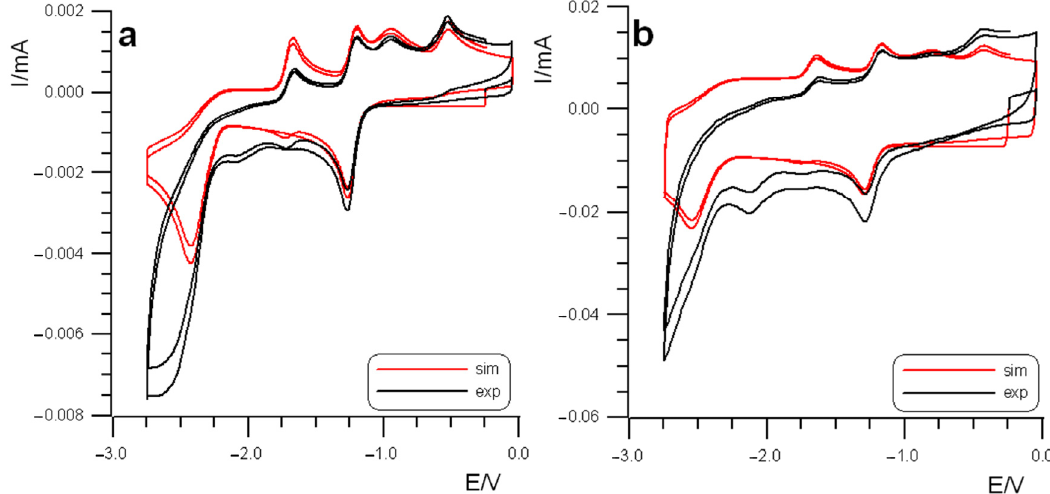
Figure 2. Simulated voltammetric curves (Antigona software version 1.0) juxtaposed on the original